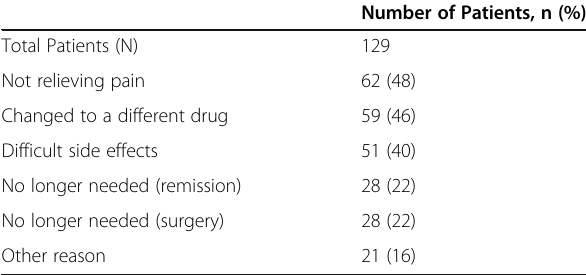
Table 5 Reasons for Medication Discontinuation a